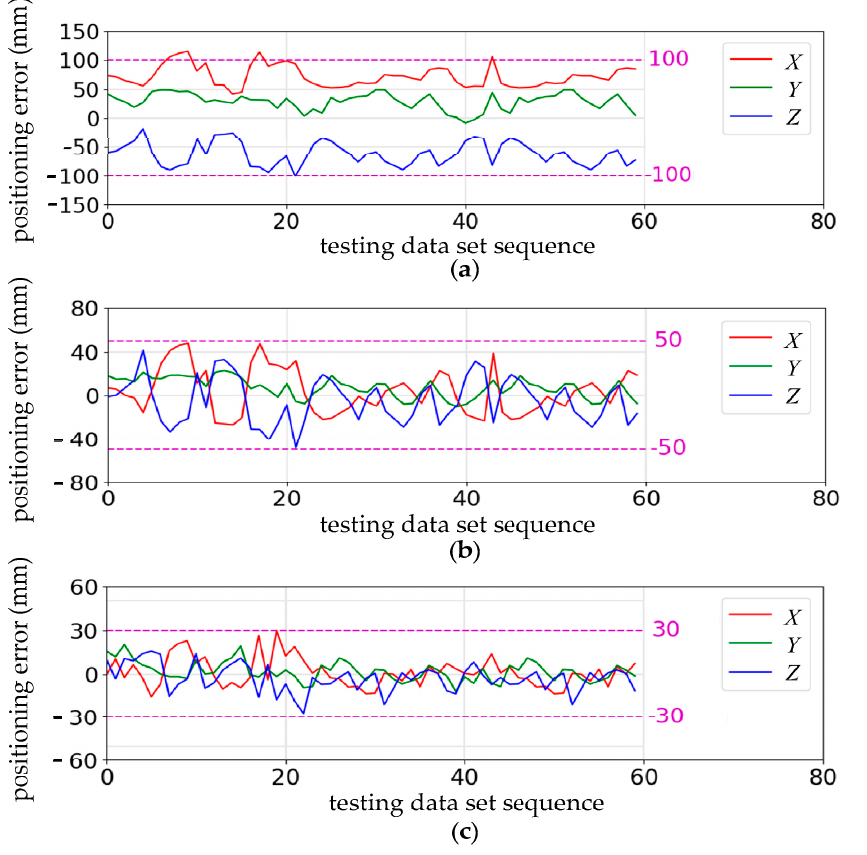
Figure 8. Positioning error contrast diagram on testing data set: ( a ) before calibration; ( b ) after the kinematics model was updated; ( c ) after the residual error was compensated.